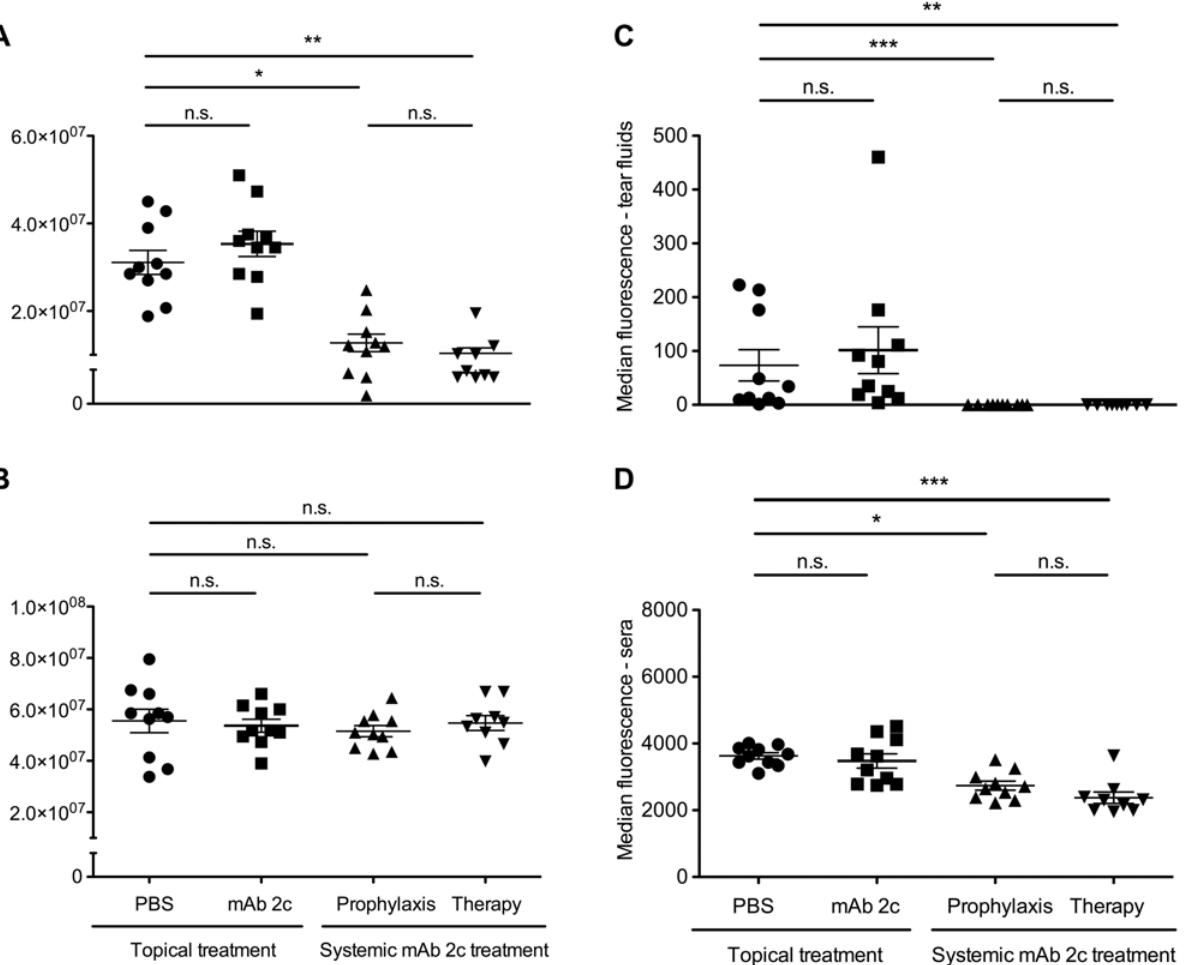
Figure 6. Influence of mAb 2c treatment on the cellular and humoral immune response to HSV-1 of corneally infected mice. The reduced virus titers correlate with reduced anti-HSV immune responses. The total numbers of cells in draining lymph nodes (DLN) (A) and spleens (B) and the relative antibody titers in 10 µ l tear fluids (C) and 60 µ l sera (D) of mice on day 14 post infection are shown. Each dot represents a single mouse. Differences between the groups were statistically significant by a nonparametric ANOVA one way test ( * P < 0.05; ** P < 0.01; *** P < 0.001). Error bars represent the